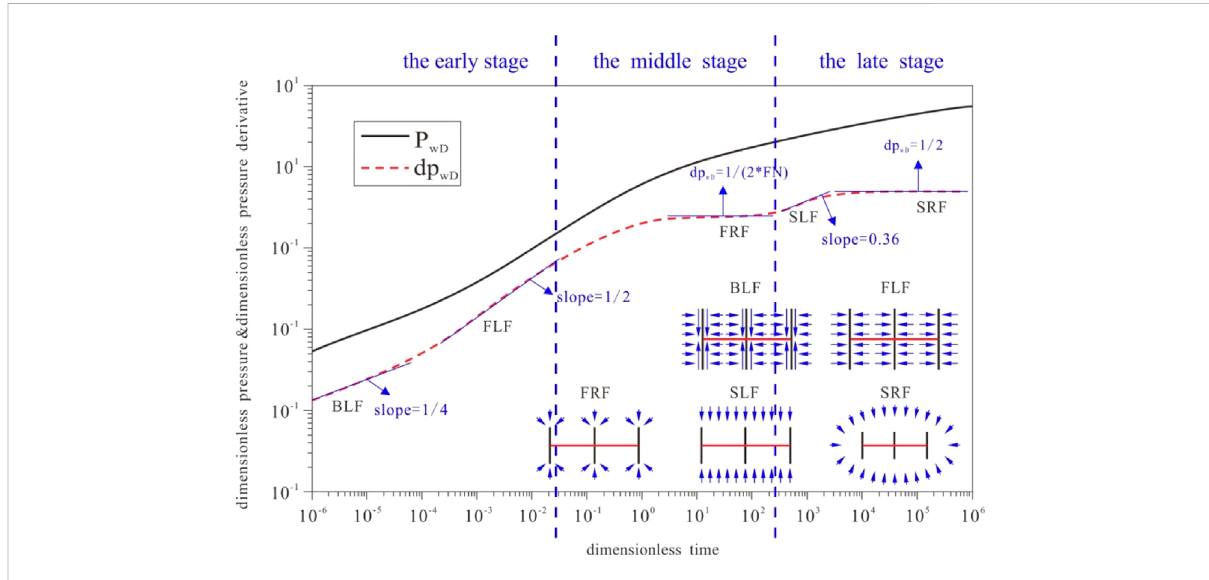
FIGURE 9 Schematic diagram of the formation pressure wave propagation for a multifractured horizontal well.